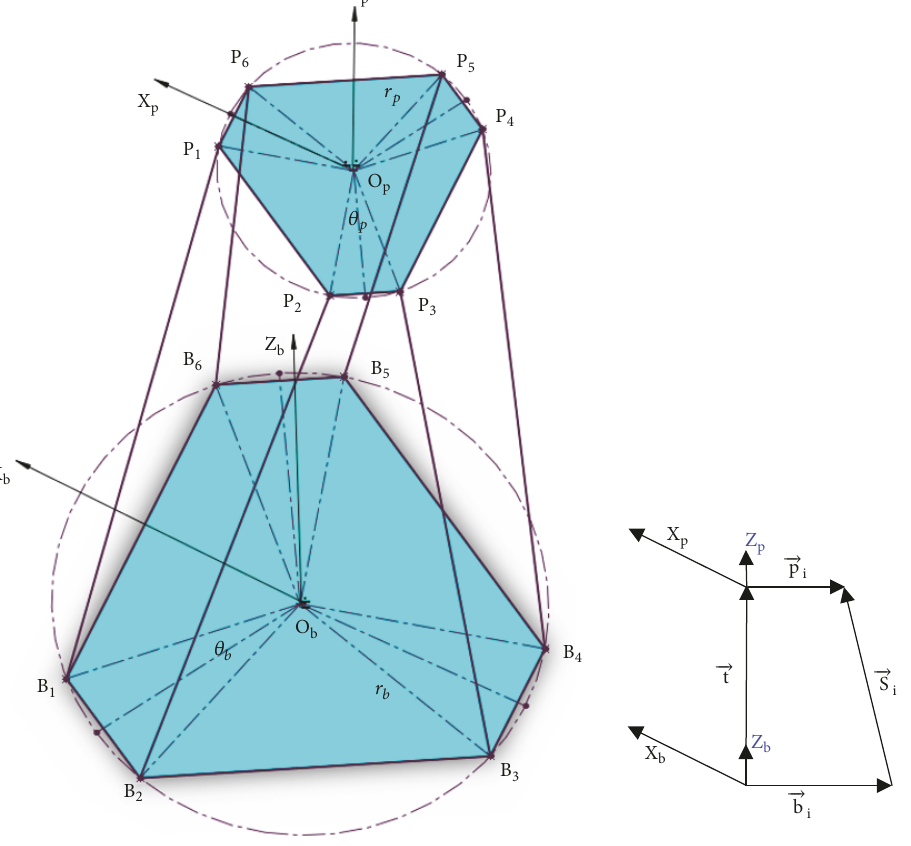
Figure 1: Coordinate systems, { P } and { B } , of